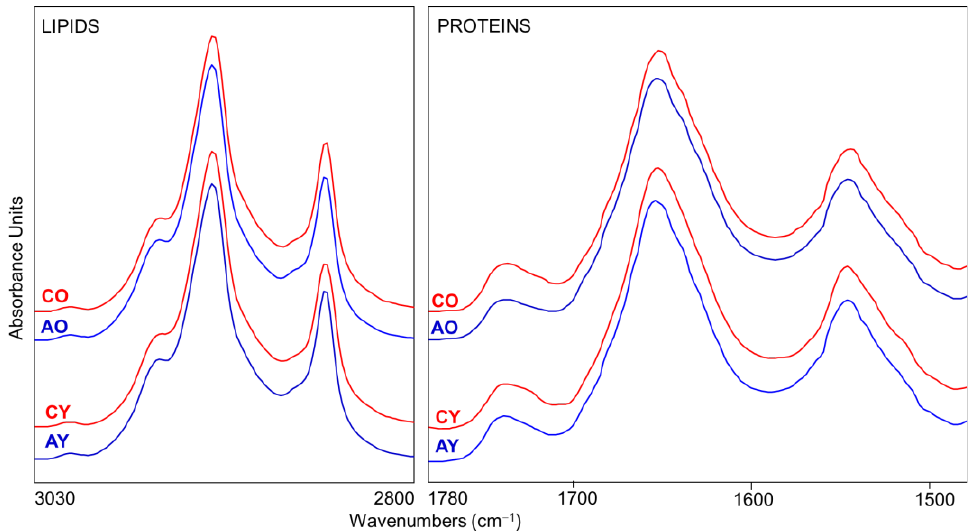
Figure 3. Average IR spectra of genu ( A , blue line) and splenium ( C , red line) regions of Y and O CC samples. Spectra are shown in the 3030–2800 cm − 1 (representative of lipids), and the 1780–1480 cm − 1 (representative of proteins) regions. Spectra are shifted along Y axis for a better comprehension.